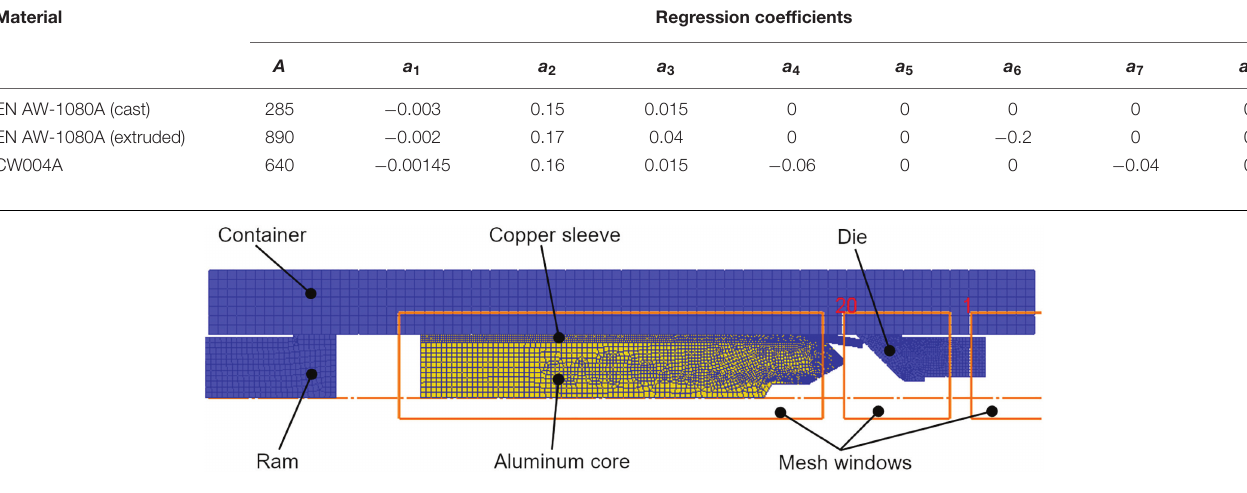
TABLE 1 | Regression coefficients of the Hensel–Spittel-equation for EN AW-1080A and CW004A. Material